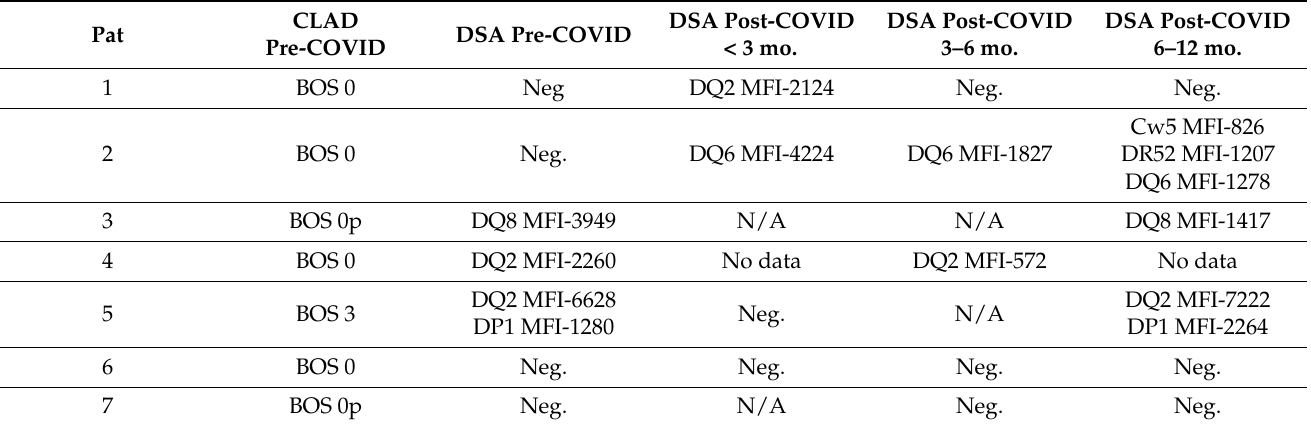
Table 3. Pre-COVID chronic lung allograft dysfunction (CLAD) and donor-specific antibody (DSA) monitoring (mild COVID).